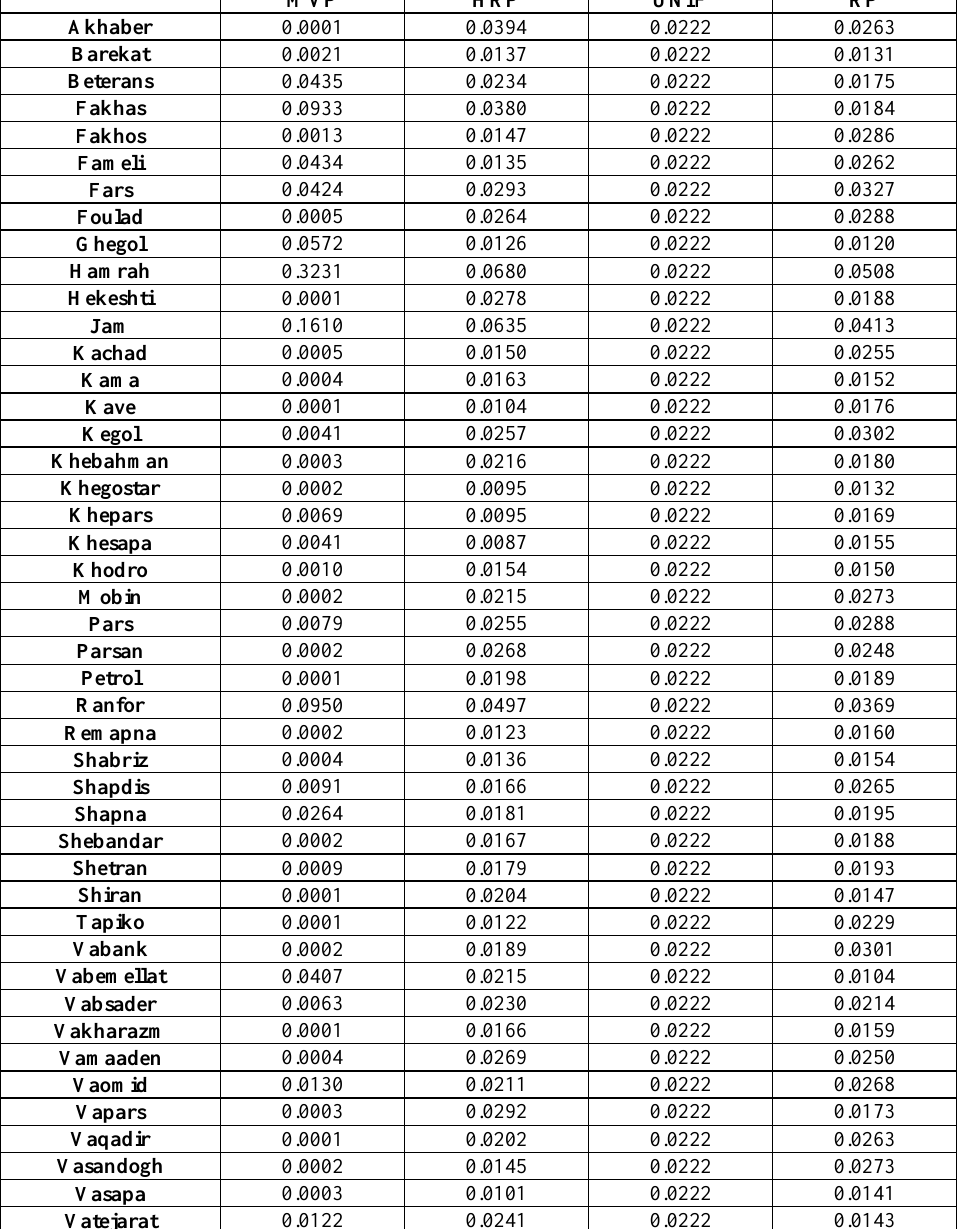
Table 3. Weight of each stock according to four types of